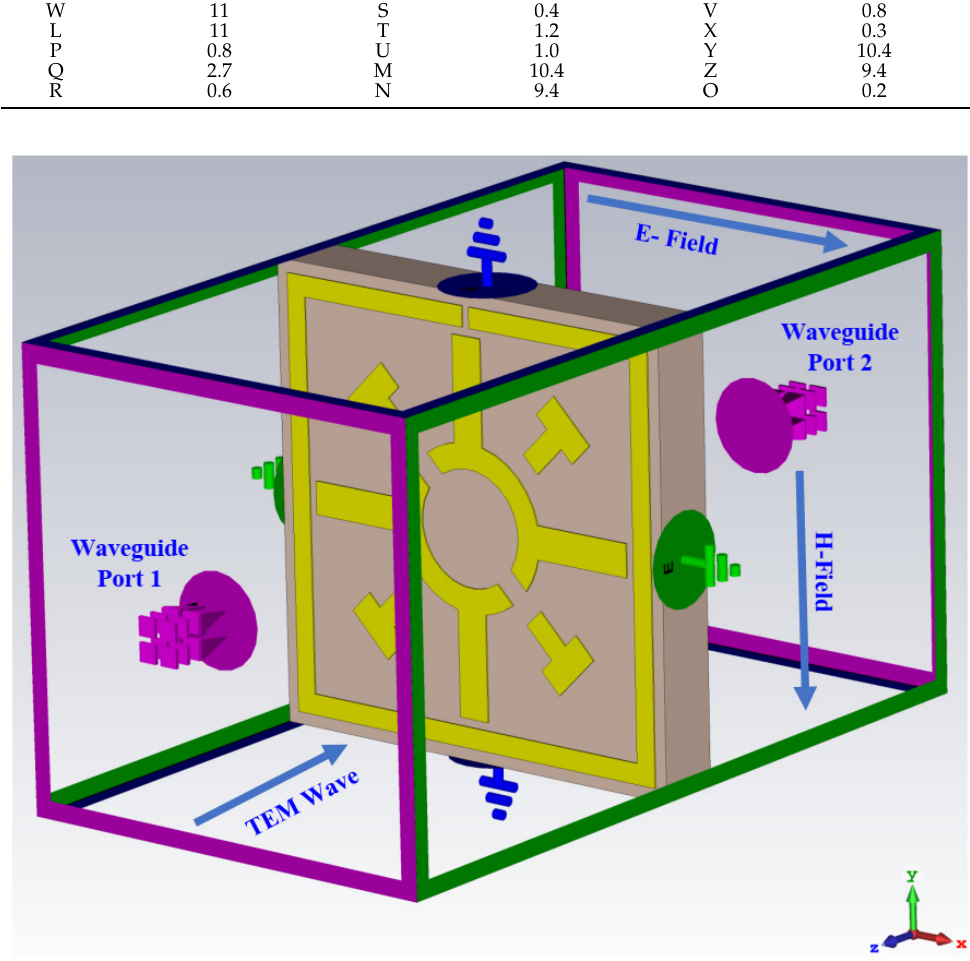
Table 1. The design specification of modified Coptic cross shape-based metamaterial.